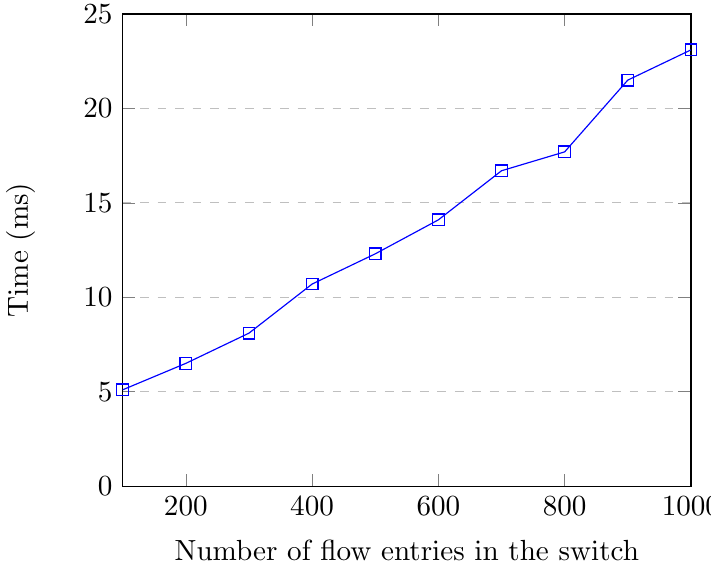
Figure 13. Feature retrieval time of 10 best features up to 1000 flow